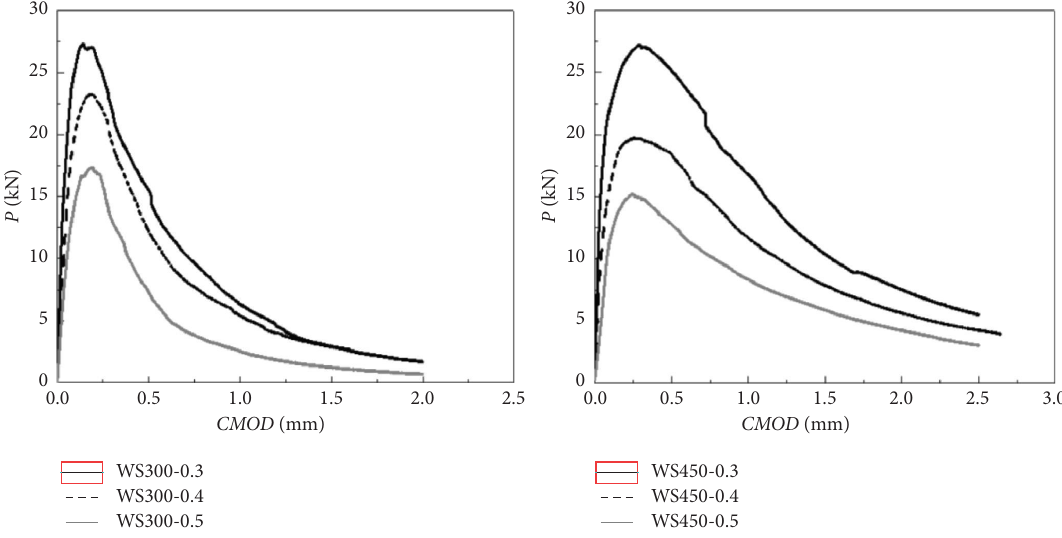
Figure 4: P-CMOD curves of hydraulic concrete specimens.